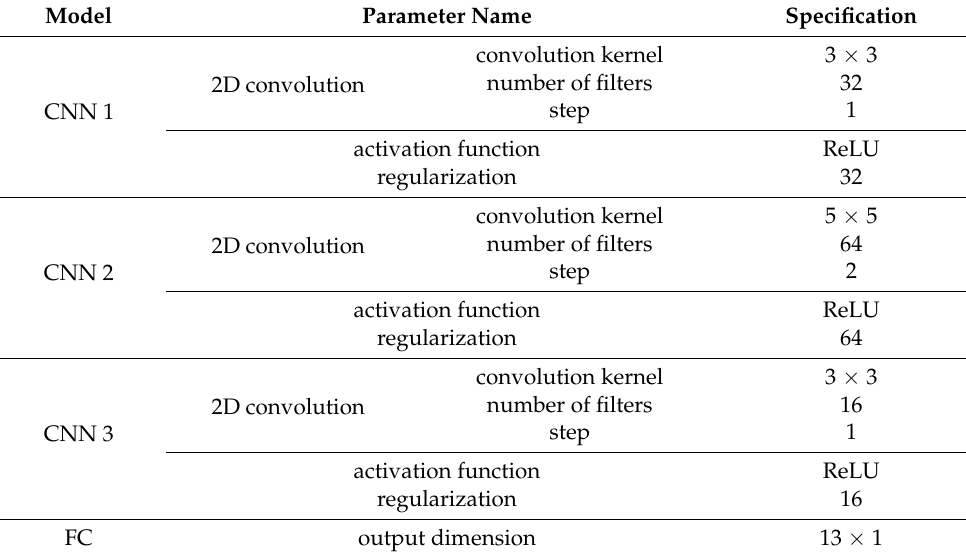
Table 1. Generator network parameters.